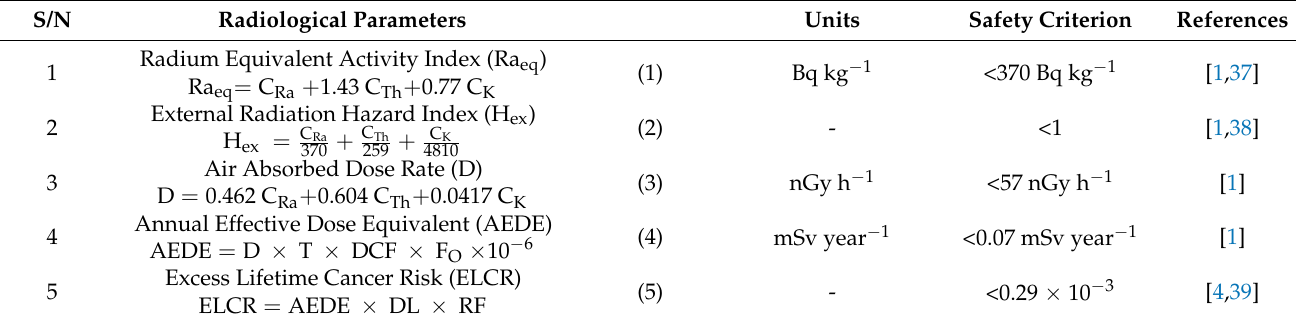
Table 1. Summary of the external hazard radiological